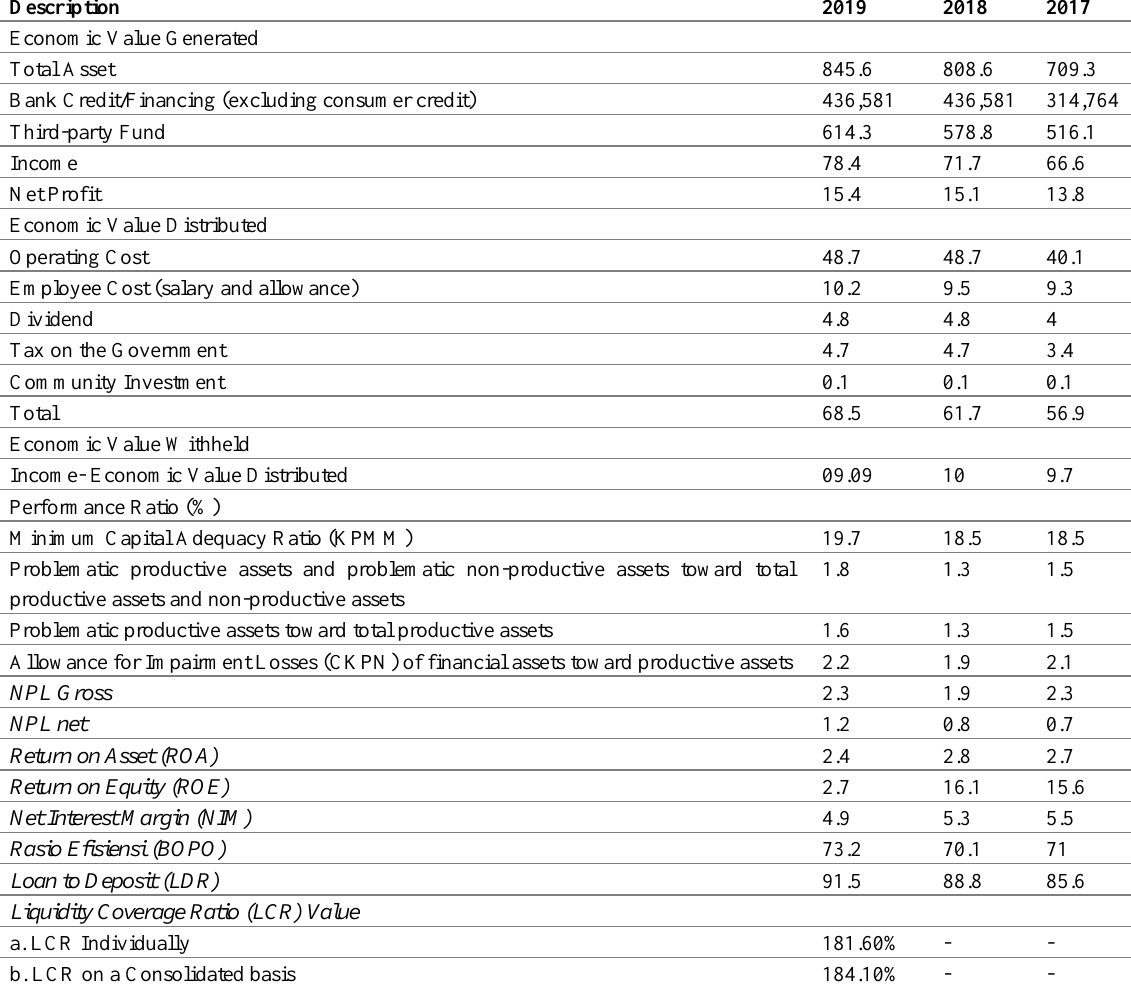
Table 1: Economic Value Growth Obtained and Distributed (IDR